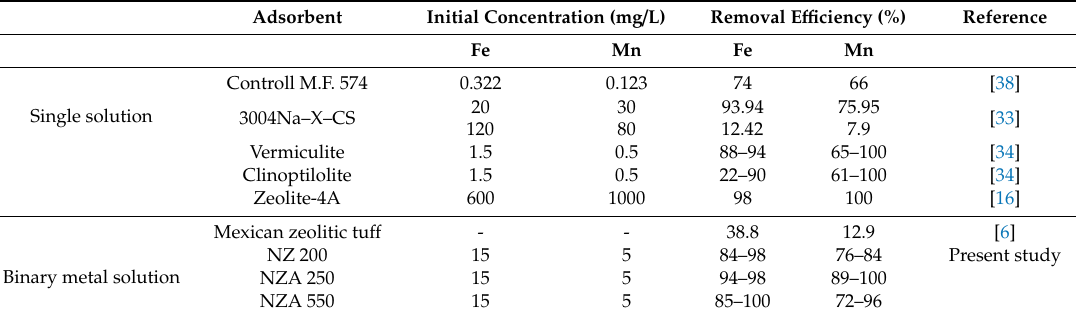
Table 3. Comparison of removal e ffi ciency for several